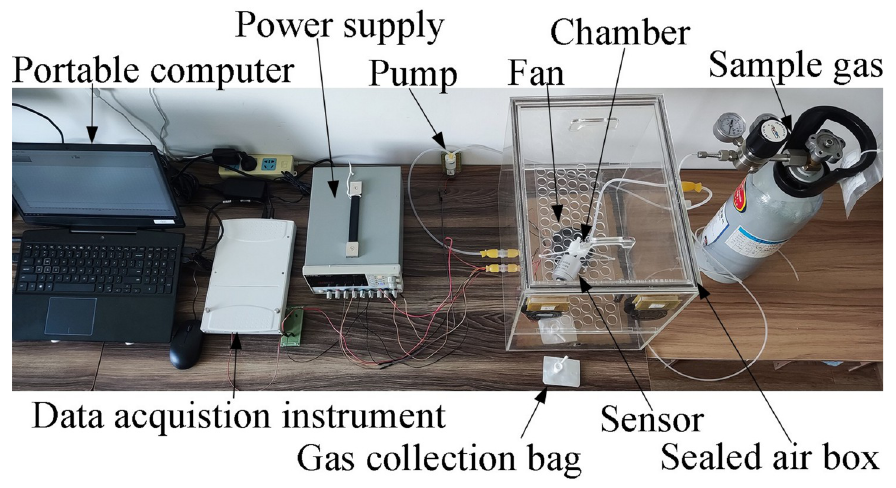
Fig 5. Experimental electronic nose detection system.